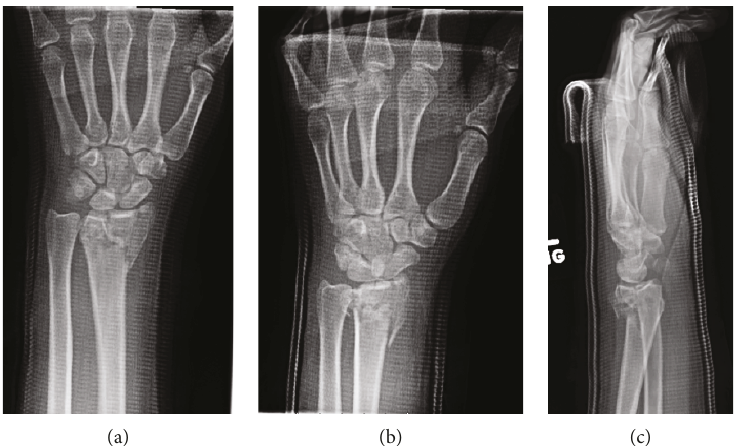
Figure 1: Radiographic presentation. Initial imaging on presentation to hand clinic after the patient was splinted at another facility.